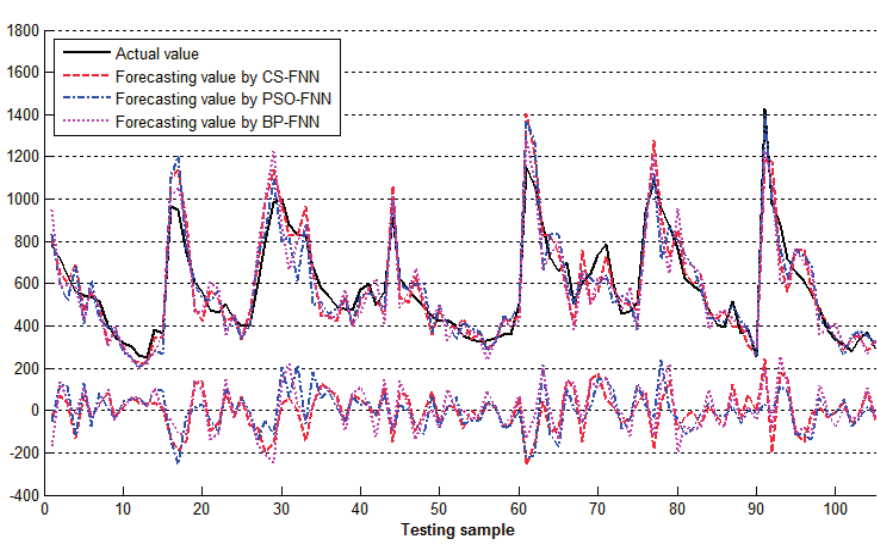
Figure 3. The forecasting and actual values in the first